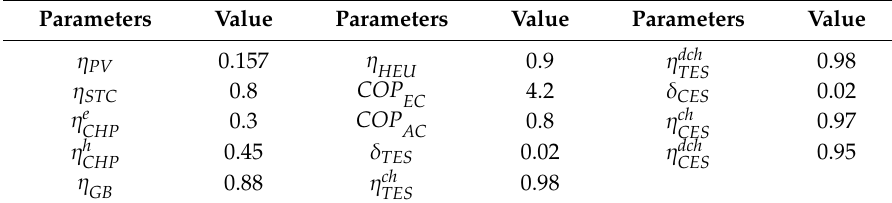
Table 1. E ffi ciency, COP (coe ffi cient of performance), and energy loss rate of relative devices.